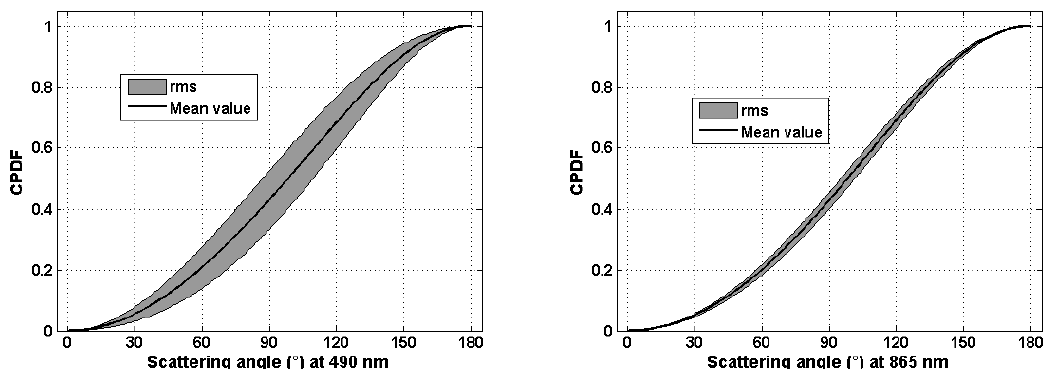
Figure B1. Cumulative probability density functions (CPDF) for the mixed forest at 490 or 865 nm, during July 2006. It was derived from the POLDER-3/PARASOL BRDFs databases. The gray areas highlight the standard